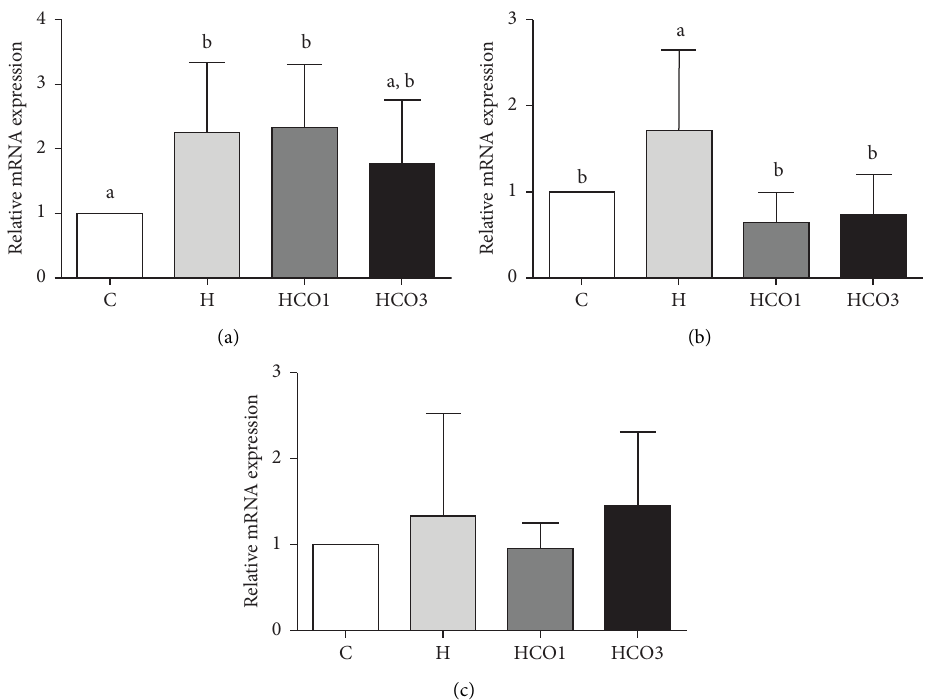
Figure 2: CYP1A2 (a), GSTA1 (b), and GSTM1 (c) messenger RNA (mRNA) expressions in the liver tissues of rats that were fed standard diet (C), HFD (H), and HFD with 1ml (HCO1) and 3ml (HCO3) per kg body weight of crocodile oil ( n � 7/group). Quantitative reverse transcription polymerase chain reaction analysis was used to examine those mRNA levels. Te data are presented as relative mRNA expression. Diferent letters in the same graph show statistically signifcant diferences between groups ( P < 0 . 05).